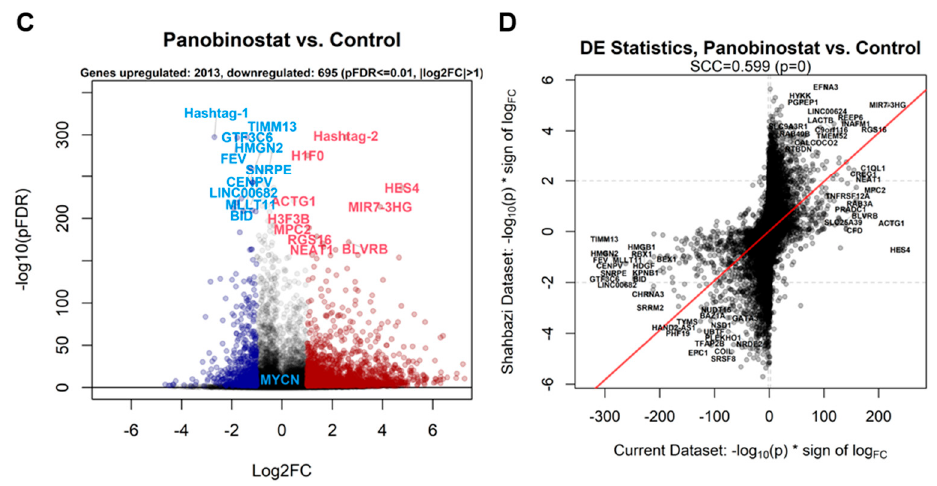
Figure 2. ( A ) Comparison between overall expression of all genes measured in our single-cell experiment (sum of all untreated Kelly cells, x-axis) and the expression of untreated Kelly cells from a bulk RNA-Seq experiment (y-axis) [22]. The Spearman’s correlation coefficient (SCC) is reported. Expression is reported as log 10 (reads per million mapped reads (RPM)). The most expressed genes in both experiments are reported alongside the MYCN paralogs MYC and MYCL, shown for comparison. ( B ) t-SNE projection of cell lines measured with bulk RNA-Seq from the previously published experiment [22], including pseudobulk counts of all cells in the current single-cell RNA-Seq experiment, divided into control (Kelly_SC_ctr) and treated (Kelly_SC_pnb) groups. Data were VST-normalized [45] prior to t-SNE analysis. ( C ) Volcano plot depicting the differential expression pattern for the contrast panobinostat vs. control, reported as log 2 fold change (x-axis) vs. − log 10 (adjusted p -value) (y-axis). Genes most upregulated in treated cells are depicted in red, genes most downregulated are shown in blue. MYCN is shown as a comparison, as it is downregulated but with a higher adjusted p -value (1.71 × 10 − 48 ). ( D ) Transcriptome-wide comparative plot of PNB-treated vs. control differential expression signatures in the current experiment (x-axis) vs. the Shahbazi microarray PNB experiment (y-axis). Signatures are expressed as − log 10 (adjusted p -value) multiplied by (*) the sign of log fold change. Genes with the greatest changes in agreement in both experiments are labeled. The Spearman’s correlation coefficient (SCC) is reported.